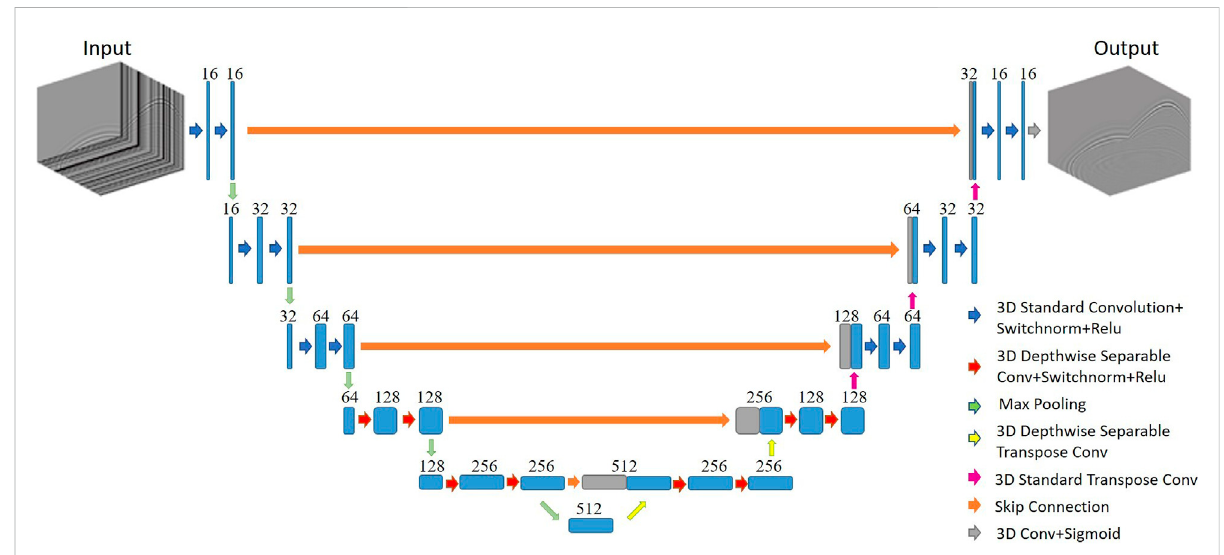
FIGURE 4 ArchitectureofDS-Unet.Theleftsideisencoder,therightsideisdecoder,andtheorangearrowinthemiddleisthejumpconnectionlayer.The red arrows and yellow arrows are depthwise separable convolution and Transpose convolution,